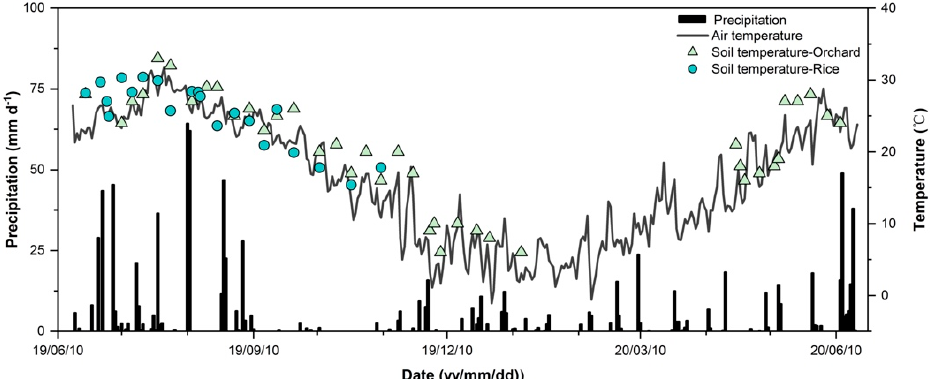
Figure 1. Mean daily air temperature, cumulative precipitation, and soil temperature (for the rice field and peach orchard) during the experimental period of June 2019–June 2020. The soil temperature break of the orchard (15 January to 23 April 2020) in the figure indicates no sampling due to the COVID-19 pandemic.